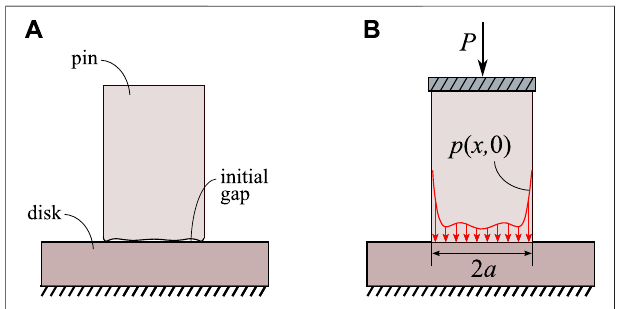
FIGURE 2 | Initial contact con fi guration: (A) Unloaded state; (B) Loaded